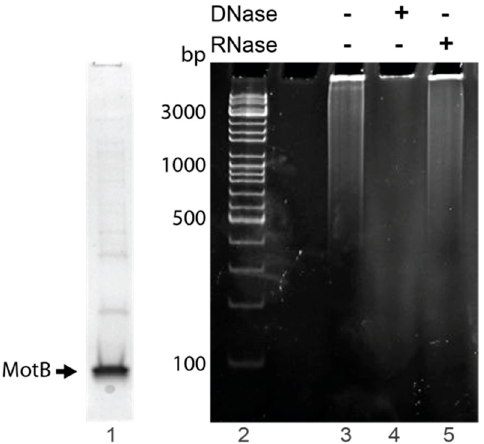
Figure 2. MotB copurifies with host DNA when heterologously produced in E. coli . Lane 1 shows an SDS-PAGE gel, stained with Coomassie, indicating the MotB protein used for the nucleic acid extraction. The agarose gel on the right shows copurifying nucleic acid (lane 3) isolated after phenol-chloroform extraction/ethanol precipitation of affinity-purified MotB and then treated with either RNase-free DNase I (lane 4) or DNase-free RNase A (lane 5). Lane 2 contains GeneRuler DNA marker (Invitrogen). Results are representative of two independent samples.